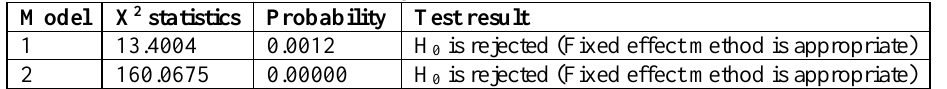
Table 3: Hausman test results for selecting between fixed effects model and random effects model Model